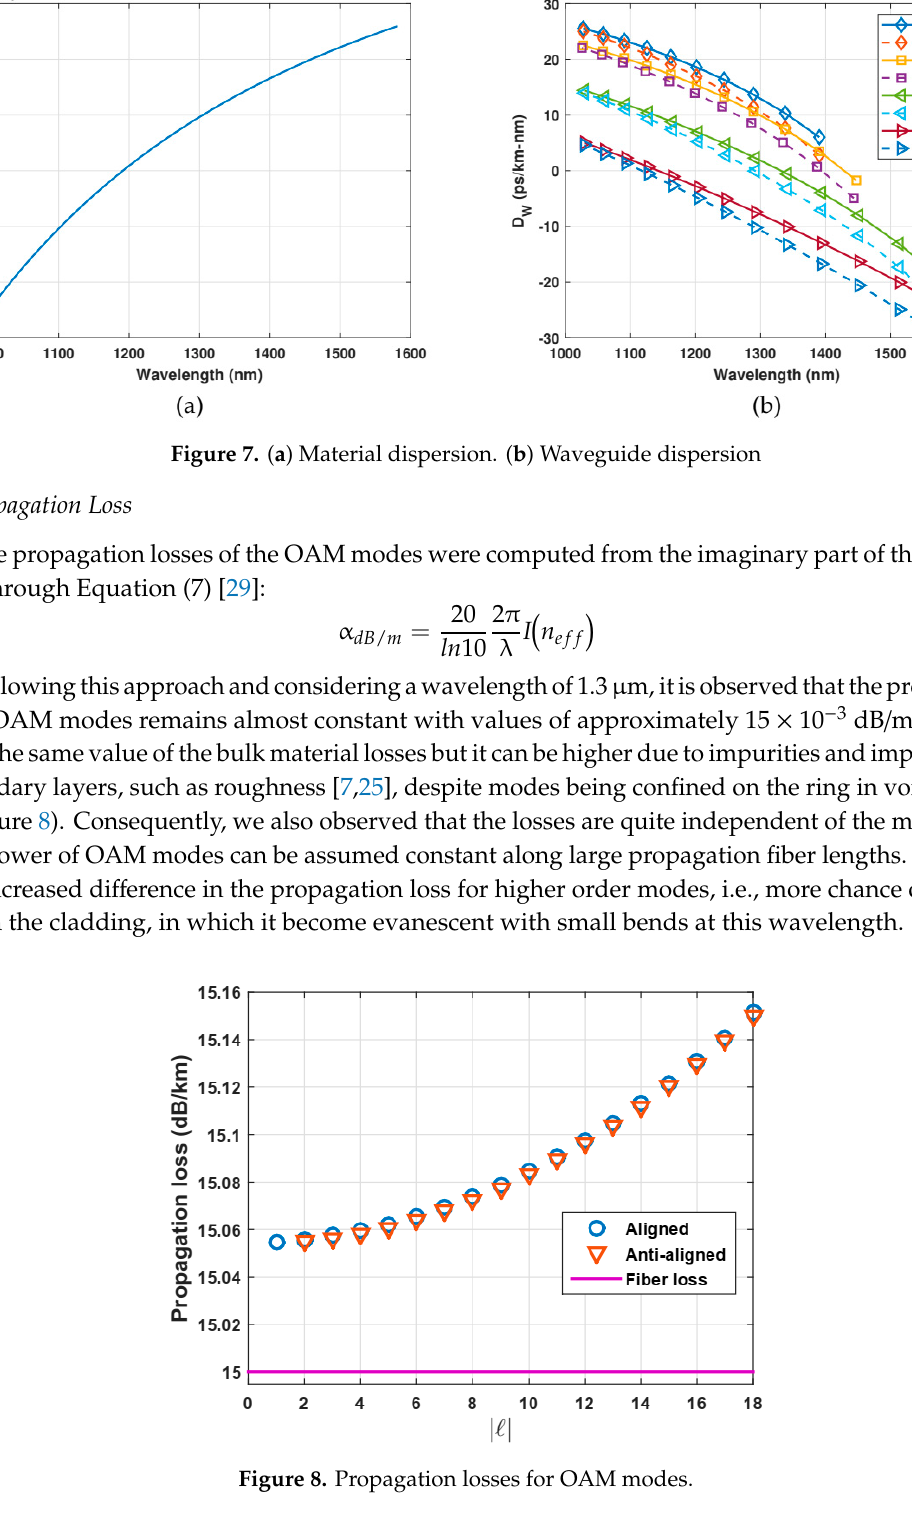
Figure 7. ( a ) Material dispersion. ( b ) Waveguide dispersion